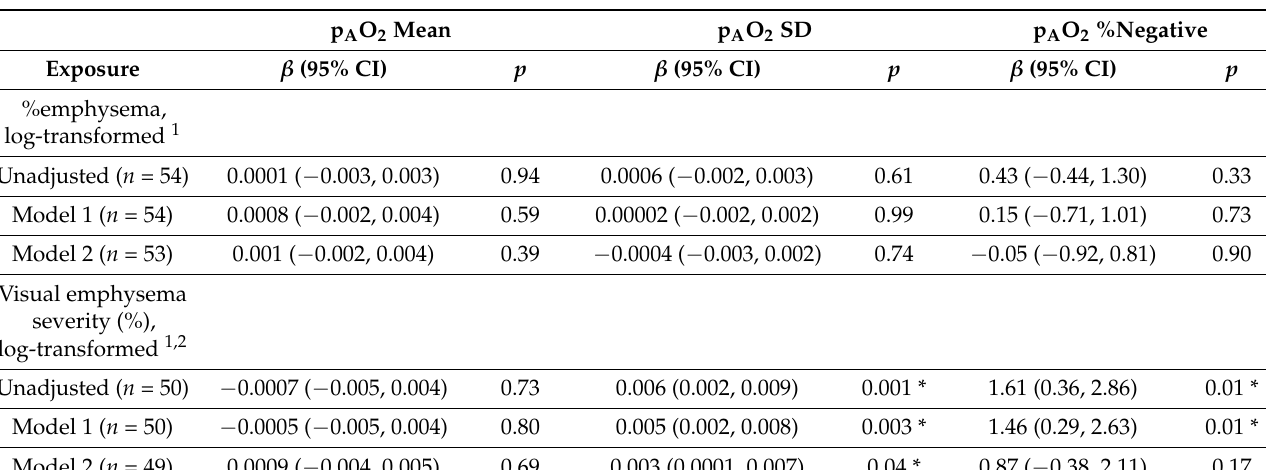
Table 5. Regional associations between percent emphysema or pulmonary emphysema